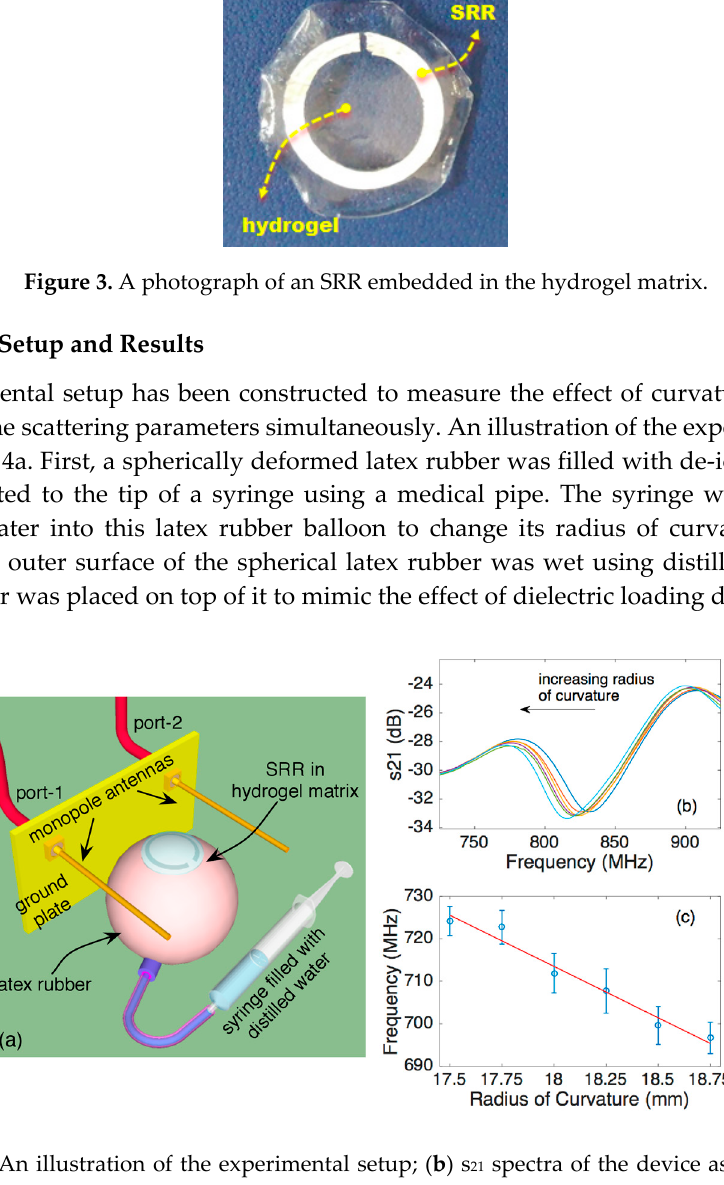
Figure 4. ( a ) An illustration of the experimental setup; ( b ) s 21 spectra of the device as the radius of curvature increases; ( c ) Variation of the resonant frequency as a function of radius of